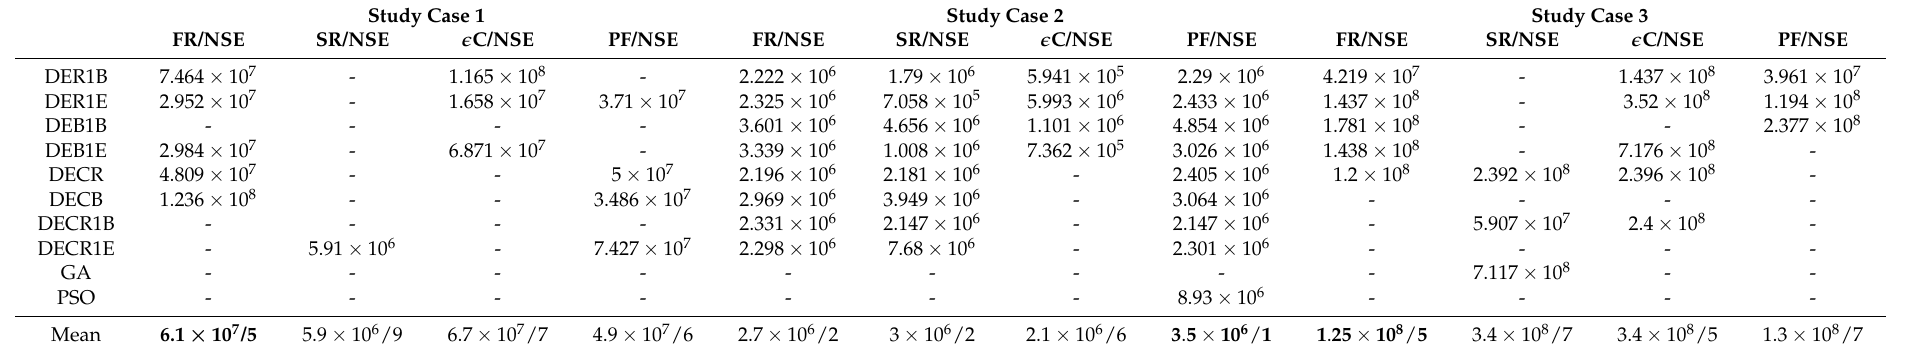
Table A15. SP metric values for each algorithm with the CHTs, and the related average values per CHTs for the three study cases. Non-Successful Executions (NSE) is represented as